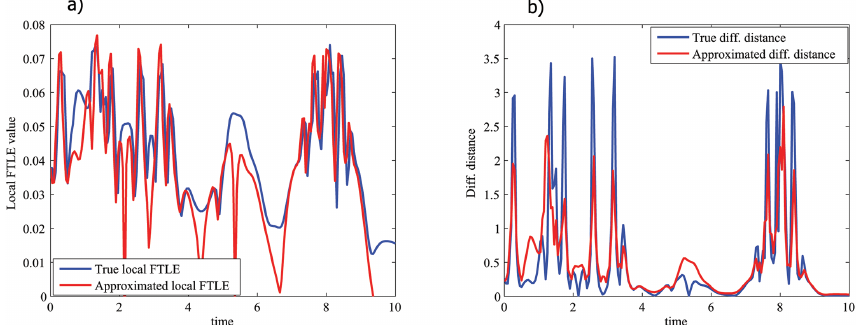
Figure 6. Observations I and II at ( x , y ) = (1.3, 1.3) for an aperiodic velocity field corresponding to a time-dependent Rayleigh–Bénard convection model. (a) Local benchmark and recovered forward FTLE. (b) Benchmark and approximated final distance between successively released particles corresponding to T =